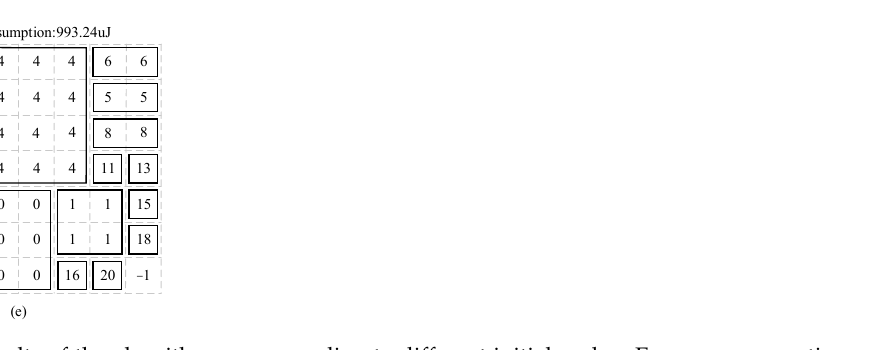
Figure 9. Results of the algorithm corresponding to different initial nodes. Energy consumption: ( a ) 1033.23 μ J; ( b ) 958.27 μ J; ( c ) 1065.59 μ J; ( d ) 943.95 μ J; ( e ) 993.24 μ J. In Figure 10a, compared with the original layout placement, all CECs of these schemes obtained by our algorithm were lower than the initial layout. The CEC of the optimal scheme was 943.95 μ J (Figure 10a), which was 22.0% lower than the initial lay- out. Figure 10b shows the 3D schematic diagram of the optimal result.